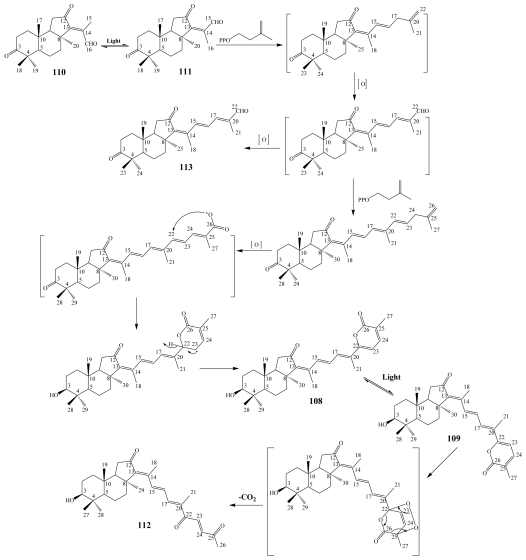
Proposed biogenetic transformation of jaspolides A–F (108–113) [101].